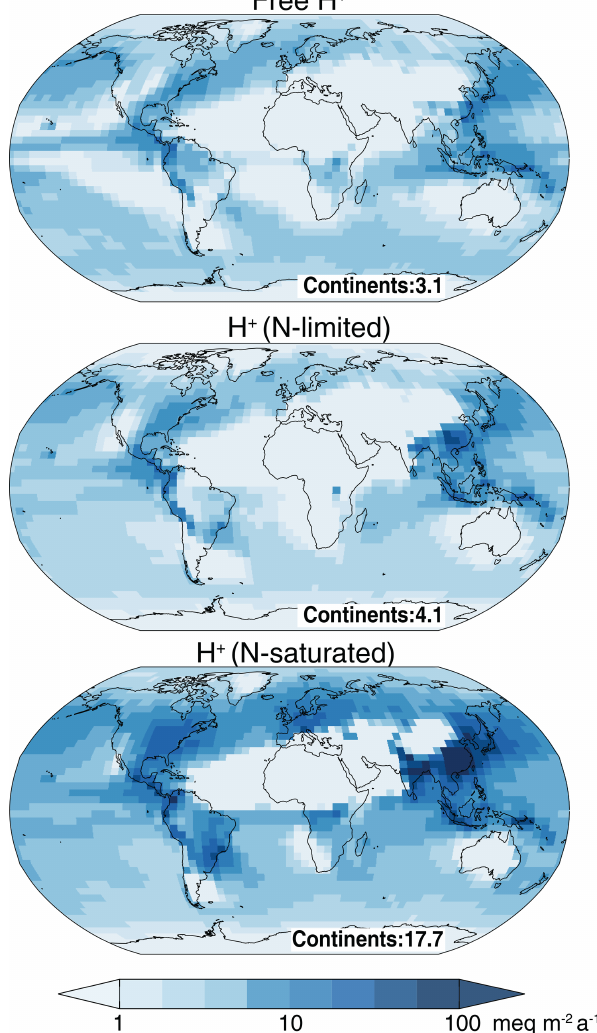
Figure 9. Acid wet deposition fluxes including post-depositional effects. Values are annual means for 2013 as simulated by GEOS- Chem. H + associated with carboxylic acids is excluded, as these acids are rapidly consumed by bacteria. The free H + flux repre- sents the direct H + input to ecosystems not accounting for any post- deposition nitrogen (N) transformation. The H + flux for N-limited conditions is computed using Eq. (7) and assumes complete assimi- lation of NO − and NH + , whereas the H + flux for N-saturated con- 3 4 ditions is computed using Eq. (8) and assumes complete nitrification of NH + and no assimilation of NO − . The global mean flux over 4 3 continents in units of milliequivalents per square meter per annum (meqm − 2 a − 1 ) is